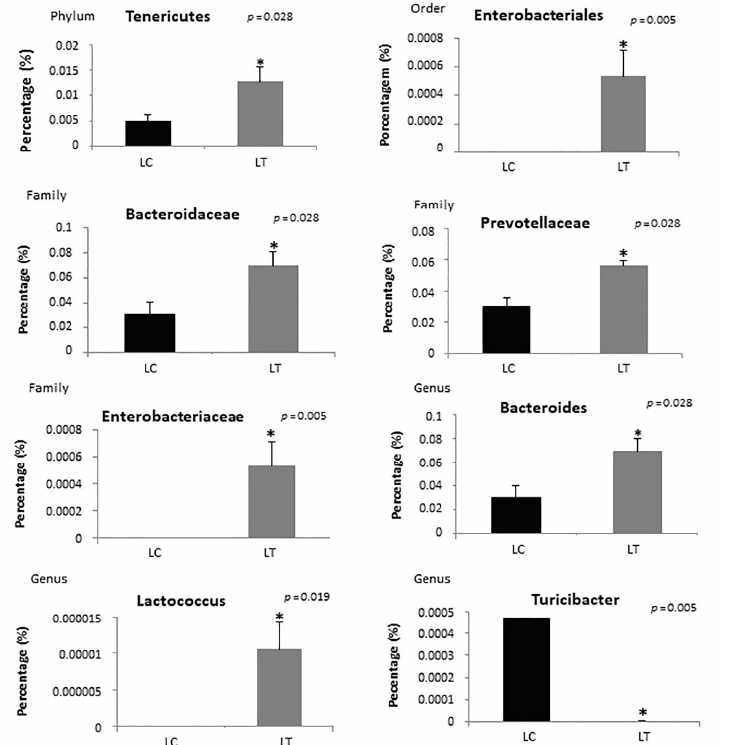
Figure 7. Analysis of the distribution of bacteria in lean control (LC) and lean treated (LT) groups according to phyla, order, family and genus. * Statistical significance.